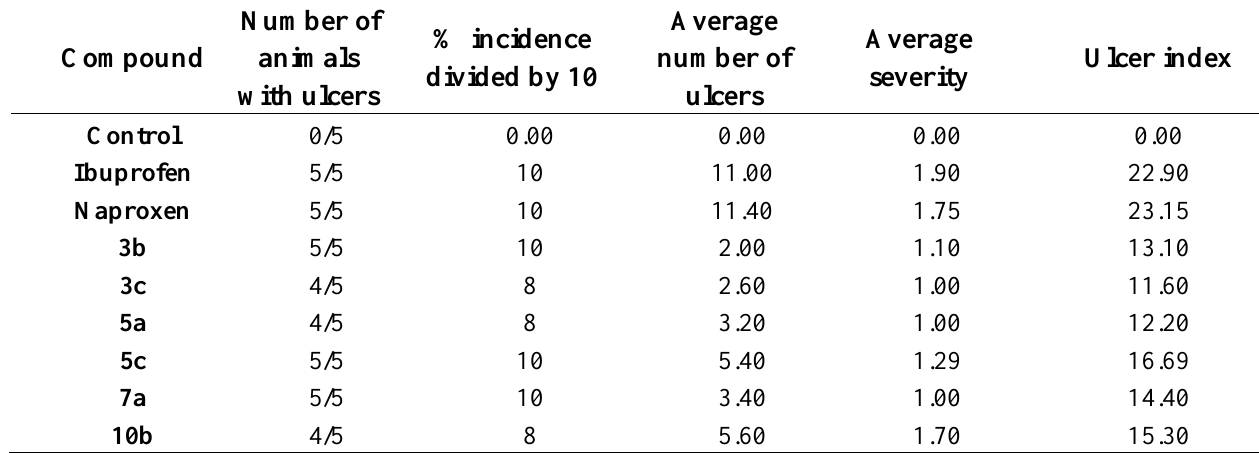
Table 2. Ulcergenic Liability of Selected